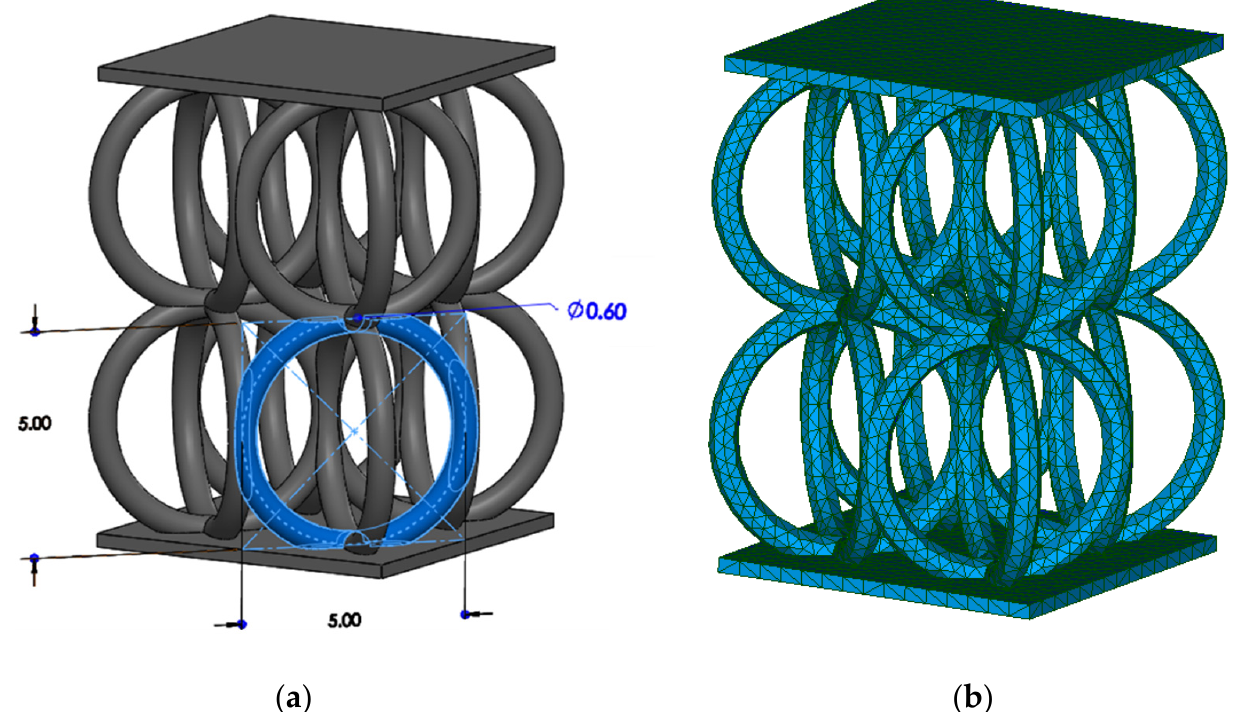
Figure 5. ( a ) A schematic of the CirC model and ( b ) the corresponding 3D tetrahedral mesh.